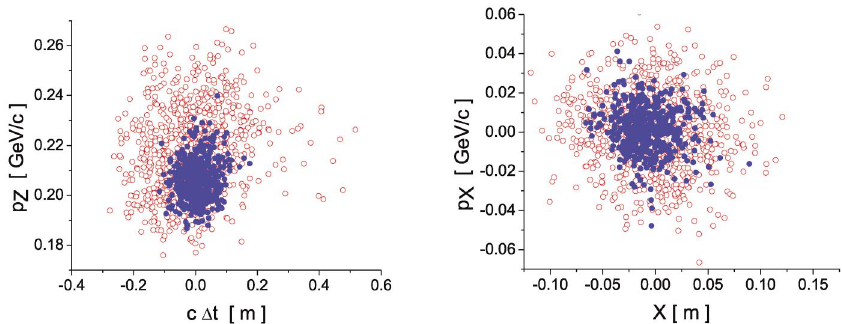
FIG. 12. (Color) Longitudinal phase space (left) and radial phase space (right) after 1 turn (open circles) and 15 turns (closed